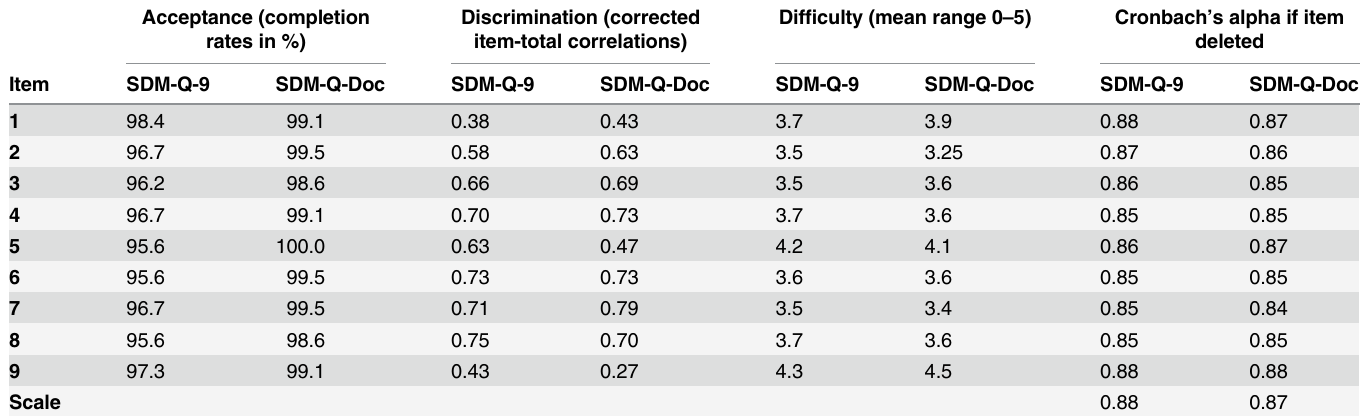
Table 3. Item Characteristics of the SDM-Q-9 and